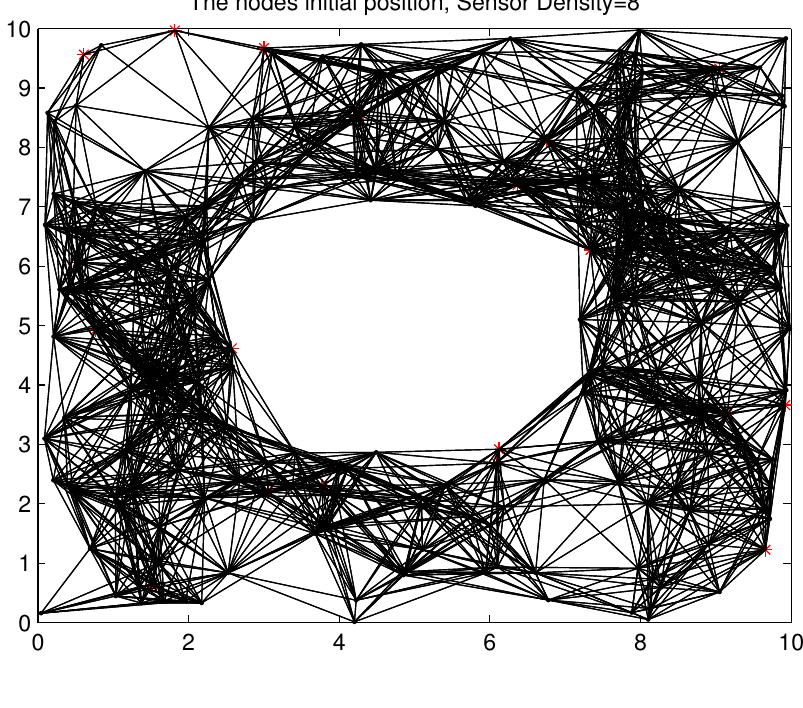
Figure 12. Initial node deployment in anisotropic O-shape network.